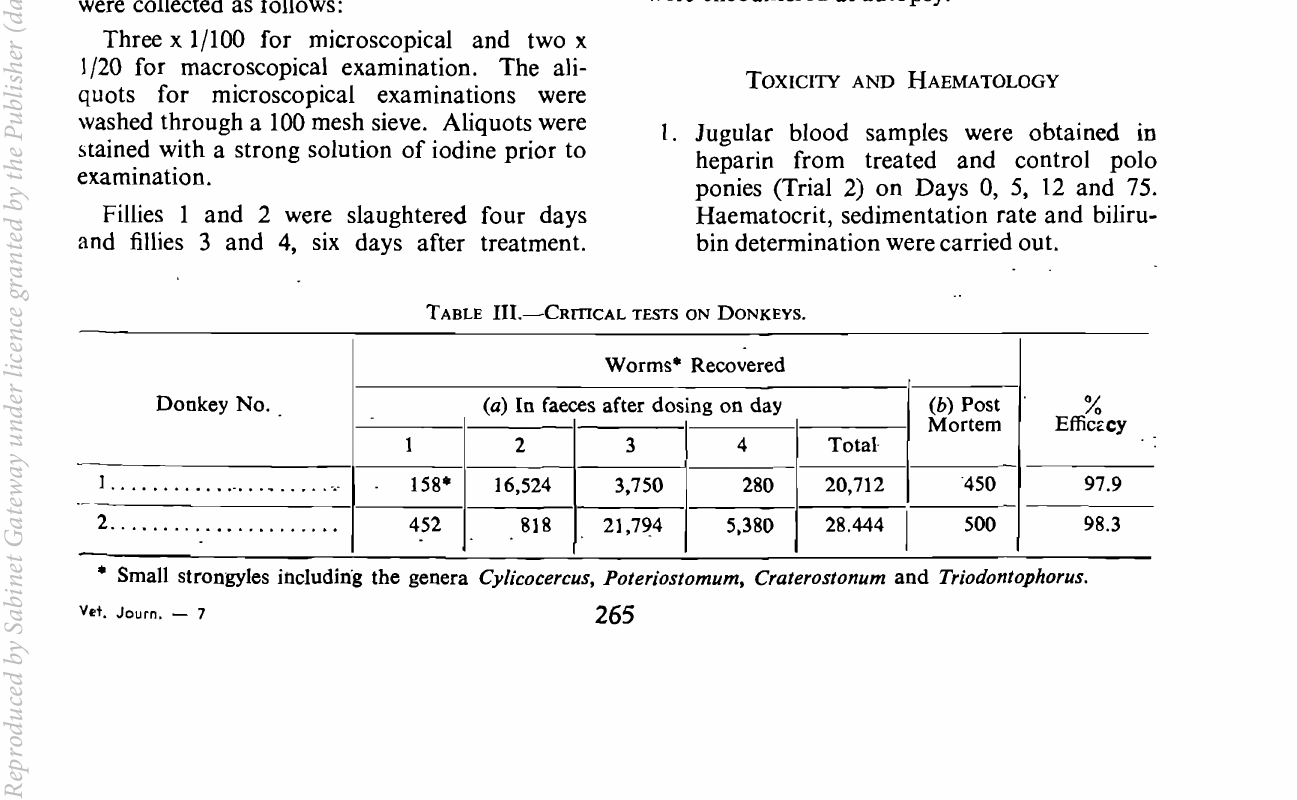
TABLE III.-CRmCAL TESTS ON